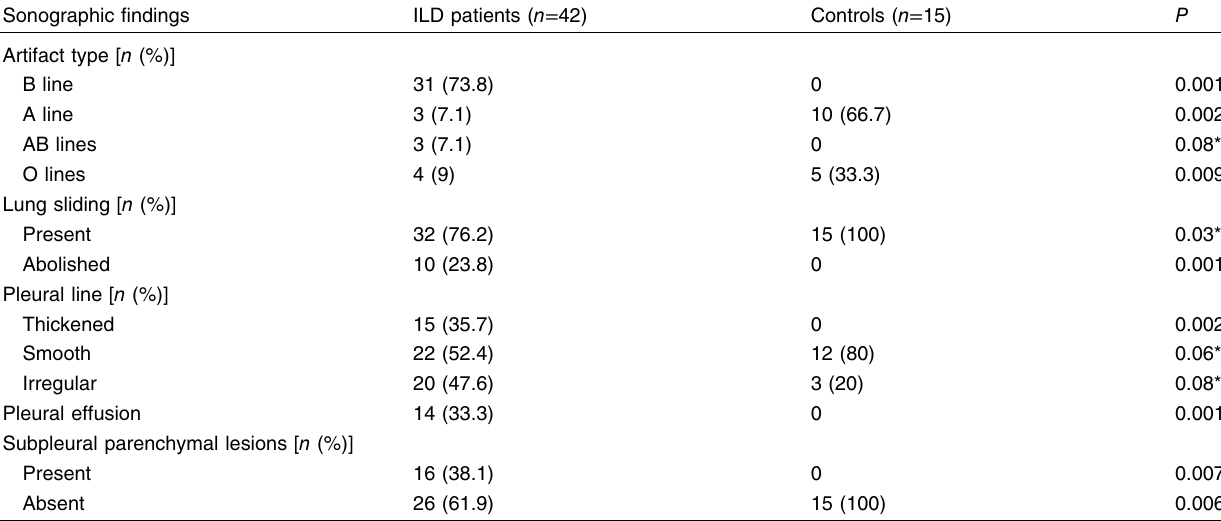
Table 3 Sonographic findings among the studied patients Sonographic